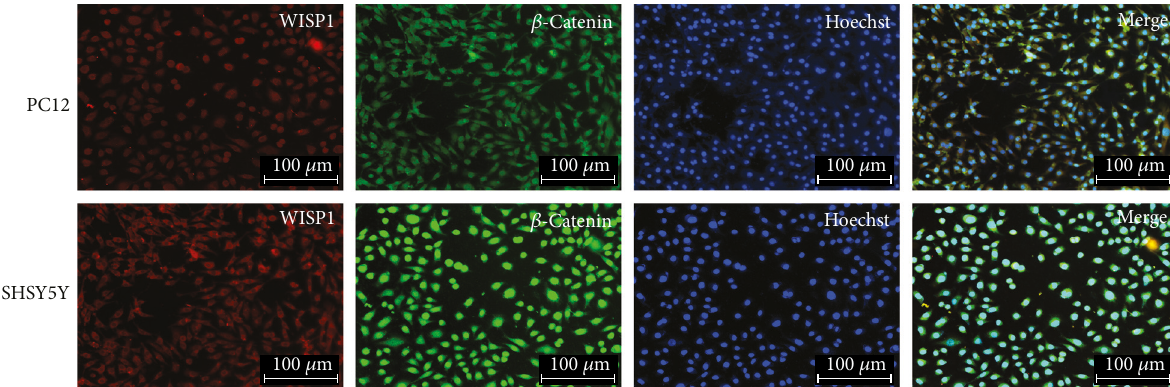
Figure 11: Double-labeling immuno fl uorescence of WISP1 in SHSY5Y with PC12 cells. Red: WISP1; green: β -catenin; blue: Hoechst; bar =100 μ m.